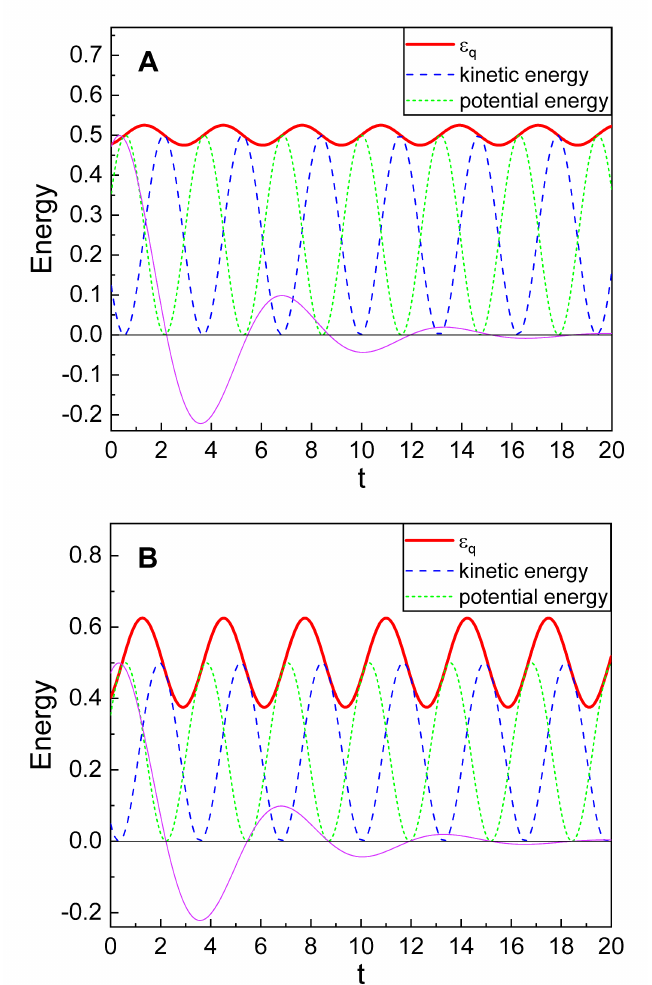
Figure 3. Quantum mechanical energy (solid red line), (under the limit ¯ h → 0), of exponentially mass-accreting oscillator given in Equation (29) with γ = 0.1 for ( A ) and γ = 0.5 for ( B ). The long dashed blue line is the corresponding kinetic energy, whereas the short dashed green line is the potential energy. A slim violet curve is the relative position of the oscillator. We used A = 1, m = 1, ω 0 = 1, and ϕ =